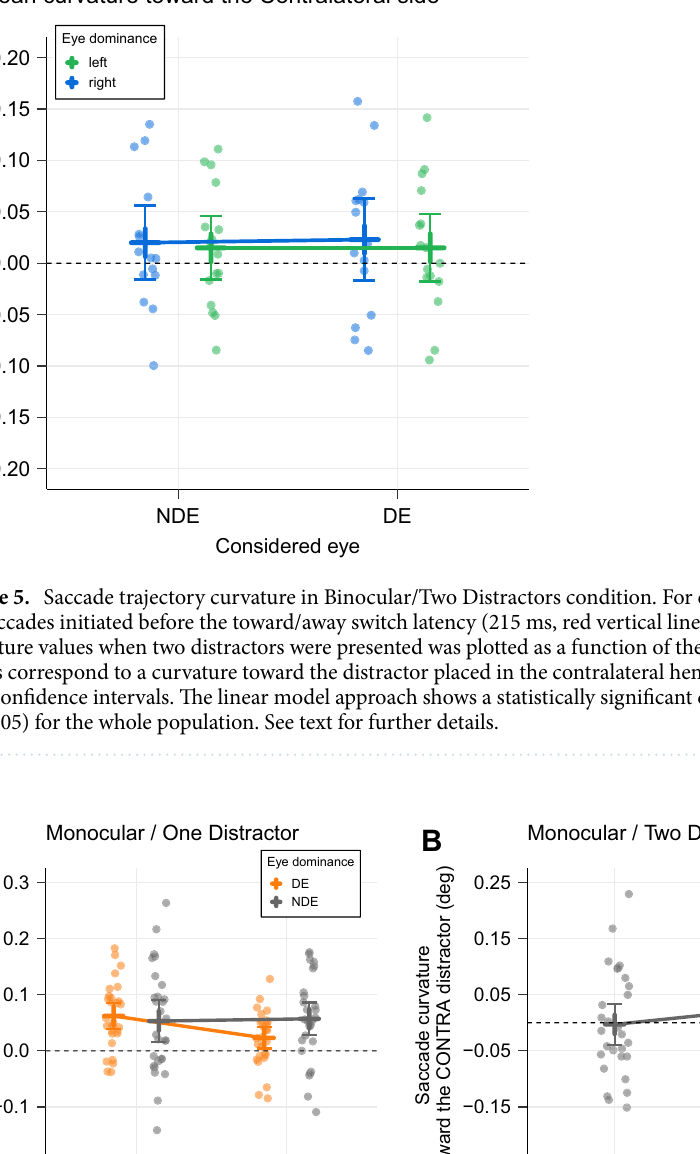
IPSI−0.2 CONTRA Figure 6. Saccade trajectory curvature in monocular conditions. ( A ) One distractor condition. For both Left and Right eye dominance groups, saccade curvature was measured for contralateral and ipsilateral distractors with respect to the Dominant Eye. ( B ) Two distractors condition. For both Left and Right eye dominance groups, saccade deviation was considered as positive when toward the distractor in the contralateral hemifield with respect to the DE. Error bars represent 95% confidence